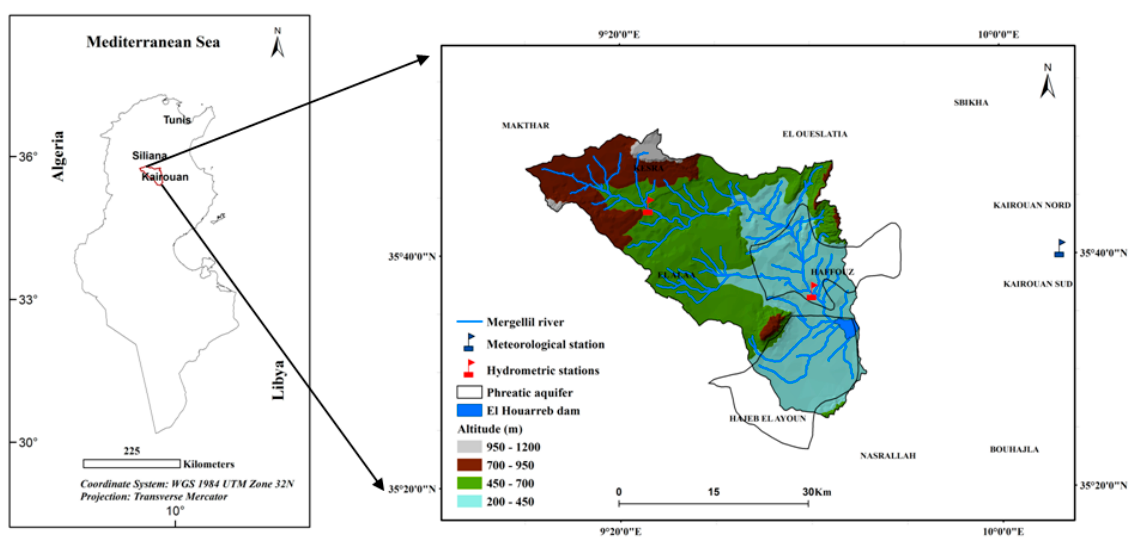
Figure 1. Location and topography of the Merguellil Wadi in central Tunisia.